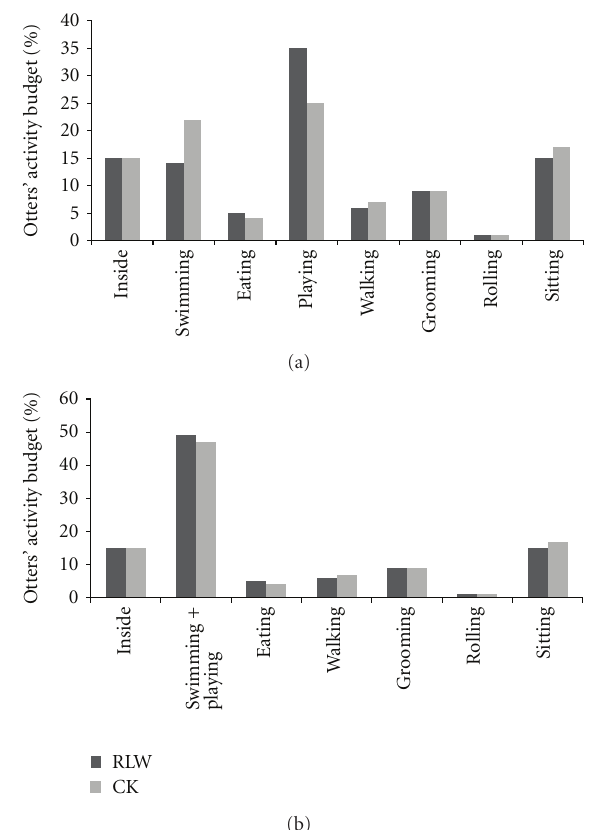
Figure 2: (a) Comparison of otters’ activity budgets calculated from ethogram data collected by two biologists (RLW and CK) over one day. Note: categories “fighting” and “other” are not displayed on the graph because neither occurred on that day. (b) As above, swimming and are playing combined as one